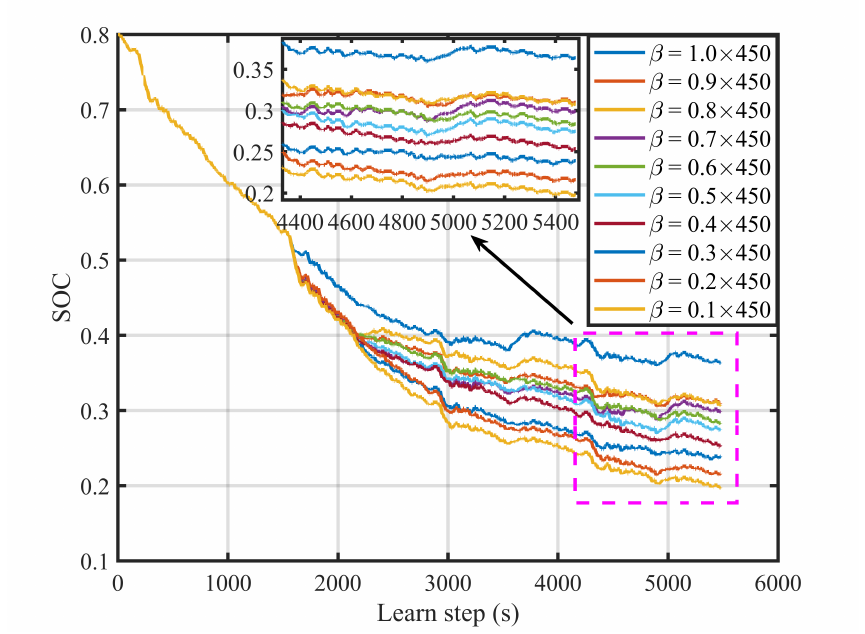
Figure 8. SOC trajectories of different β in 4 × UDDS. Table 3. Simulation results comparison between different β